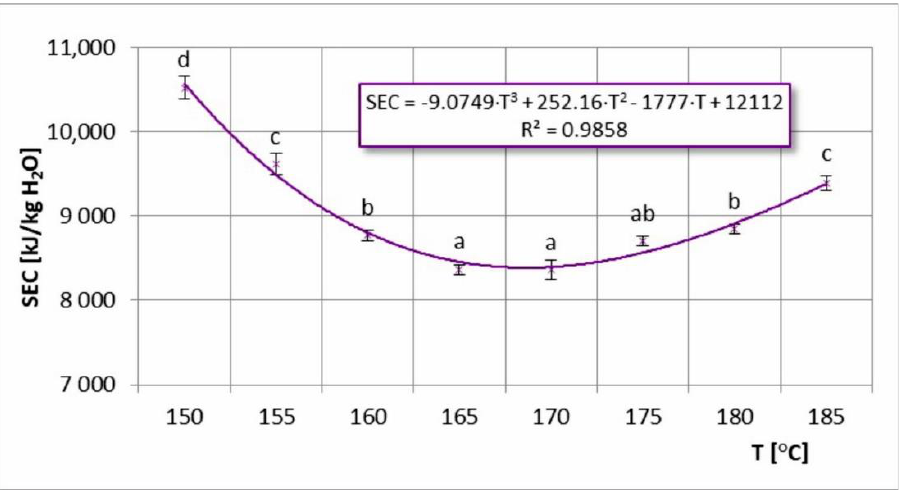
Figure 7. Specific energy consumption (SEC) in the process of spray drying chokeberry juice at different inlet air temperatures (T); (a, b, c, d—different letters show significant differences between mean values ( p ≤ 0.05)).